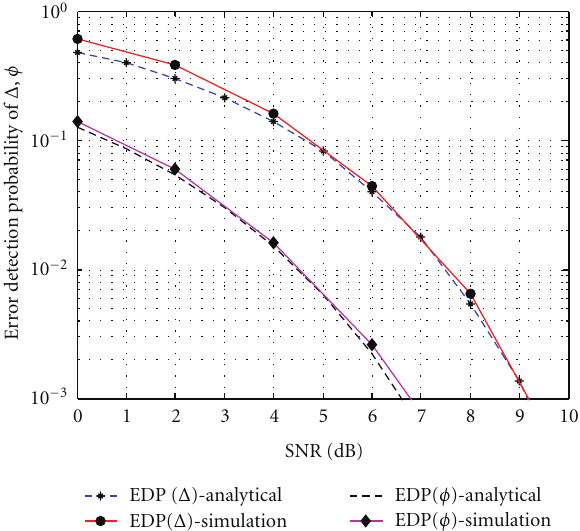
Figure 16: Analytical and simulated error detection probability.